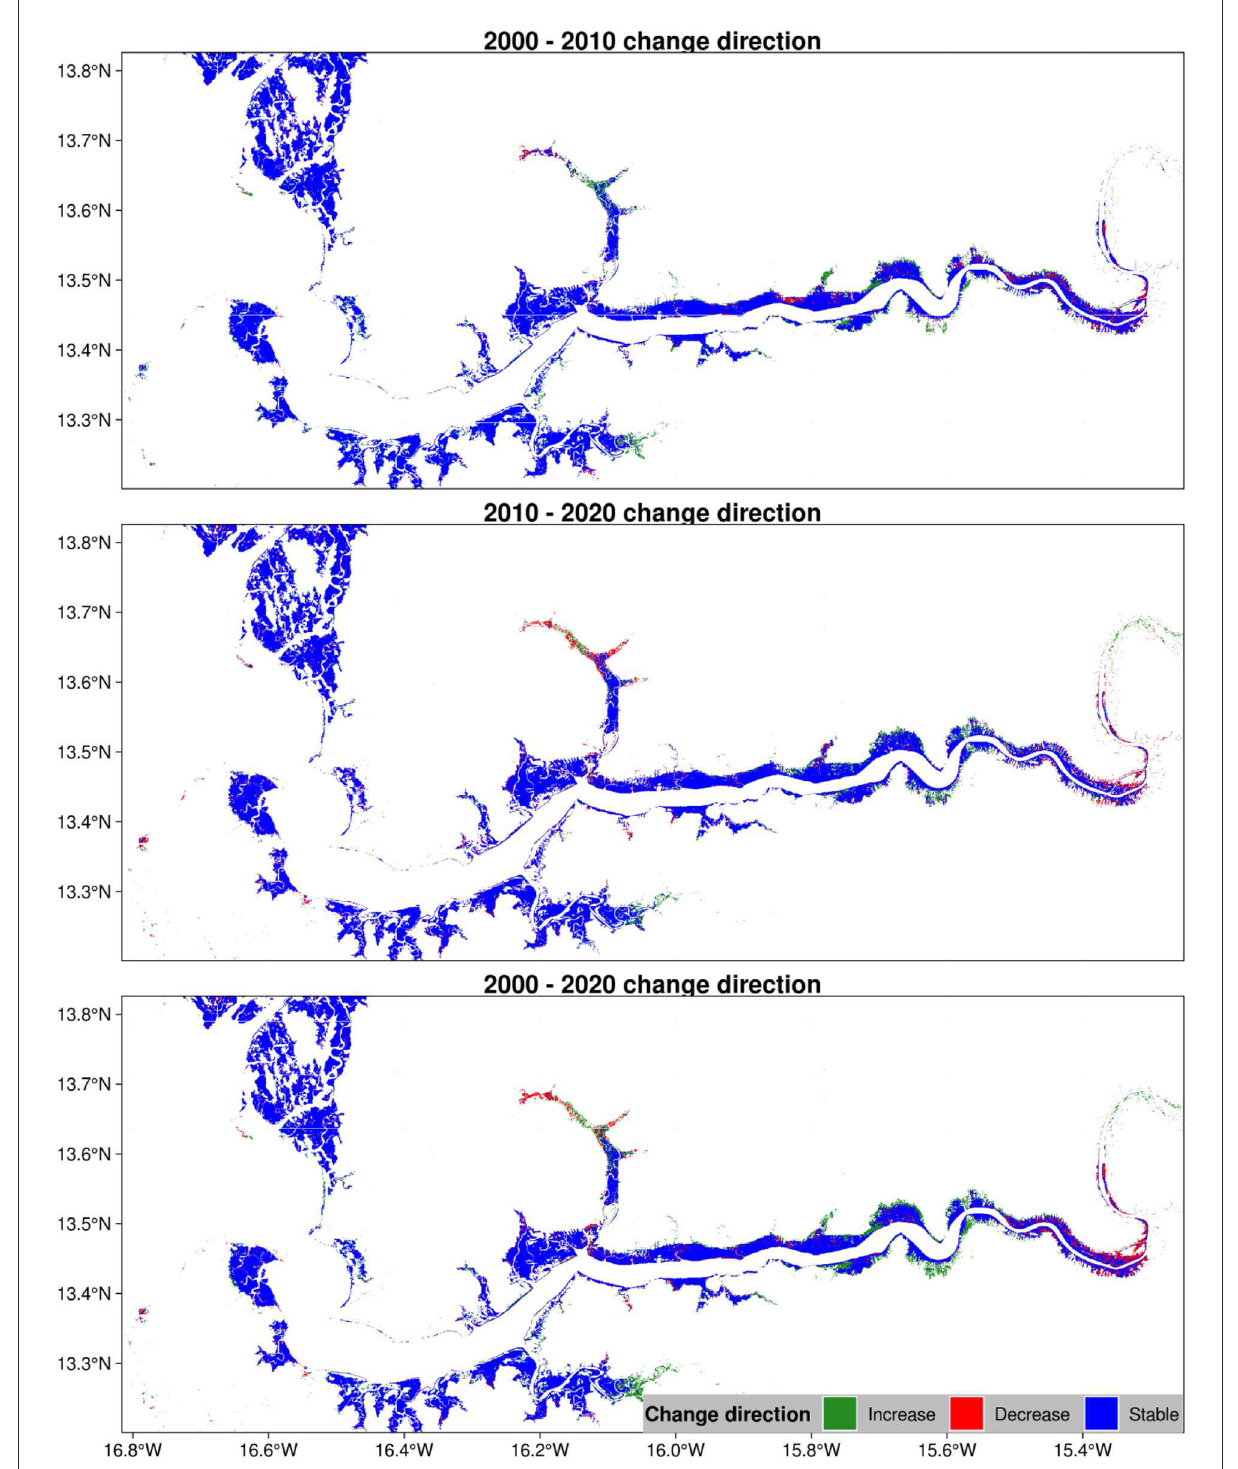
FIGURE5 Change direction in mangrove vegetation cover of The Gambia based on harmonic modeling and classification of Landsat and MODIS time series. This figure was cut off to exclude empty space for better visualization.